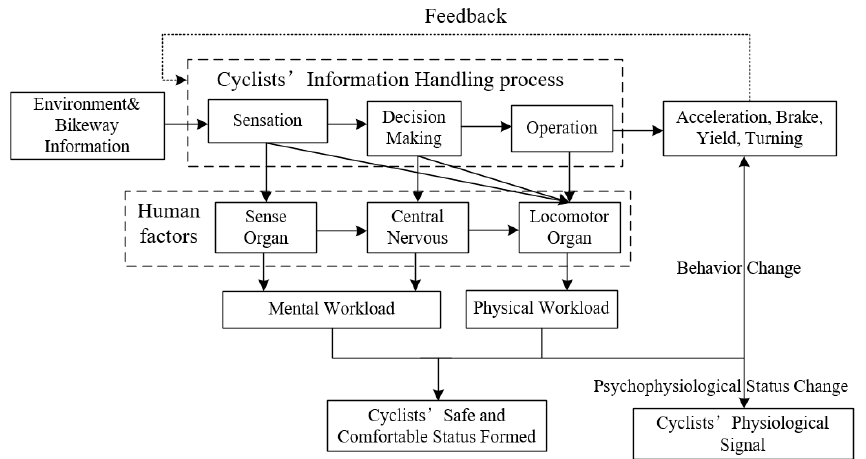
Figure 1. Cycling safety and comfort during cycling task.